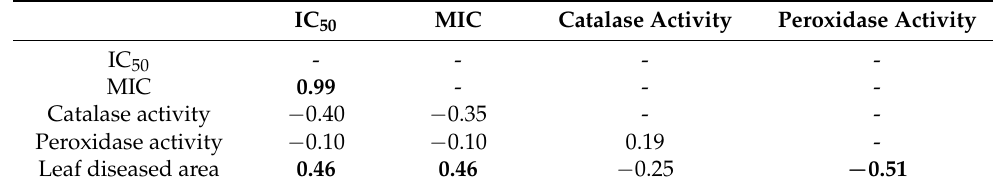
Table 3. Correlations between protection efficacy and both direct (IC 50 and MIC) and indirect (plant catalase and peroxidase activities) effects of the tested RLs, as well as dodecanol and lauric acid, obtained on the wheat- Zymoseptoria tritici